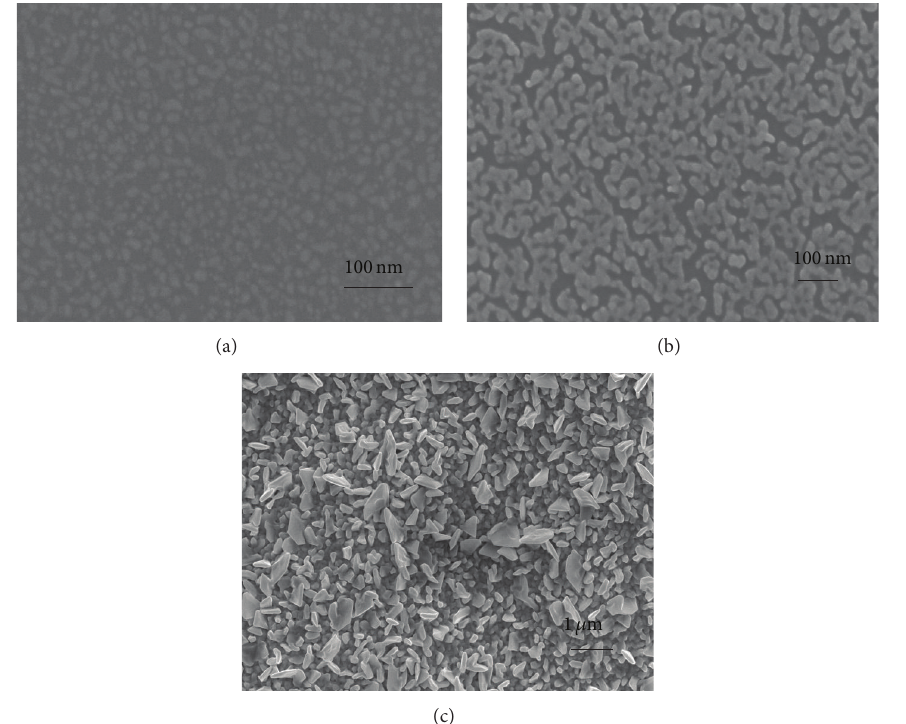
Figure 2: SEM images of GaAs (100) substrates immersed in dilute HAuCl 4 solution. HAuCl 4 concentration and deposition duration were (a) 0.7 mM; 20 s, (b) 1.0 mM; 30s, and (c) 1.0mM; 60 min.